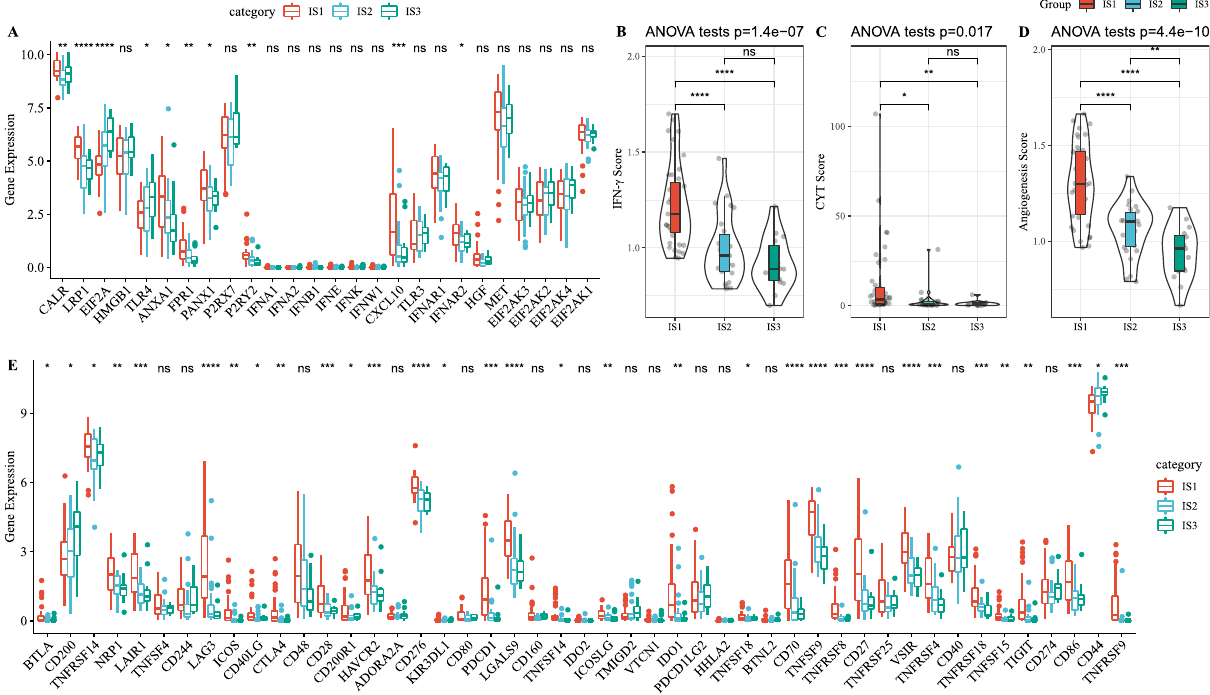
Figure 3. Associations between ISs and classical markers and immune checkpoints of chemotherapy-induced immune response. ( A ) Difference in expression of classic markers of chemotherapy-induced immune response in the three IS samples. ( B ) Differences in IFN-γ scores among the three ISs. ( C ) CYT score differences between the three ISs samples. ( D ) Differences in angiogenesis score among the three ISs. ( E ) The expression of 47 immune checkpoint-related genes differed in the three ISs. * P < 0.05; ** P < 0.01; *** P < 0.001; **** P < 0.0001; Ns: not